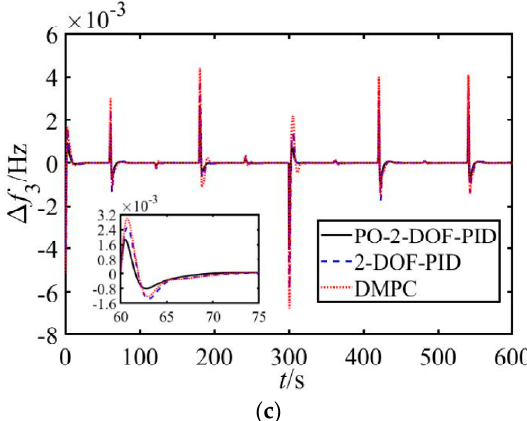
Figure 7. Frequency response of power system in high wind speed. ( a ) Area1 ( b ) Area2. ( c ) Area3.